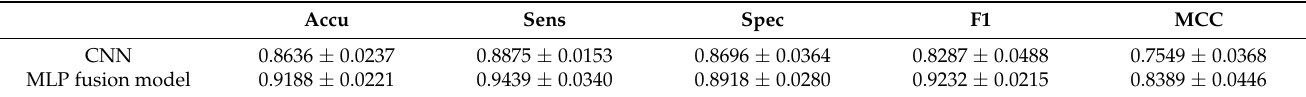
Table 5. The experimental results of the CNN model and the MLP fusion model.